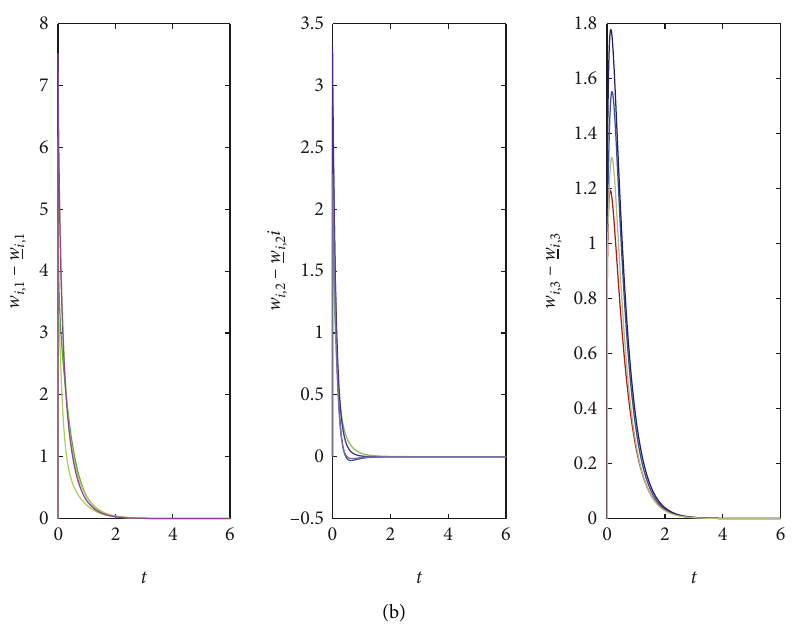
Figure 2: Reduced-order NIO-based consensus. (a) Trajectory of w